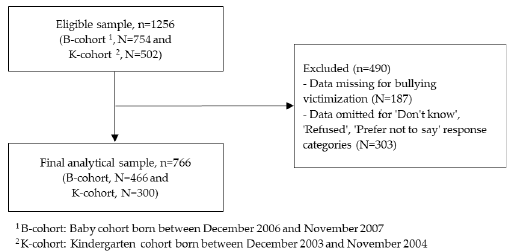
Figure 1. Flow diagram showing the selection of samples in the final analysis.